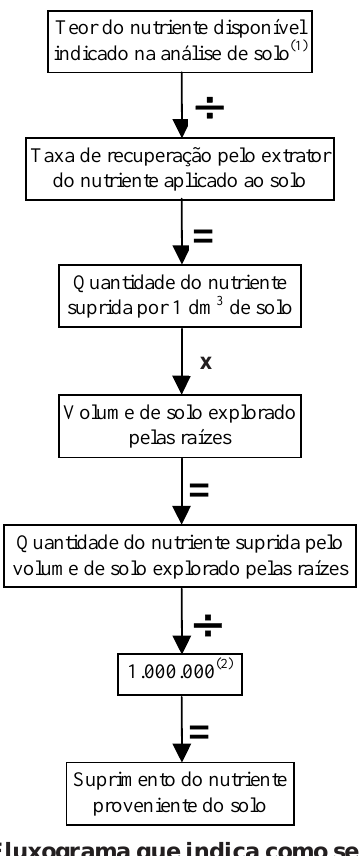
Figura 2. Fluxograma que indica como se estima o suprimento de um nutriente proveniente do solo. ( (1) Os teores de todos os nutrientes deverão ser expressos em mg dm -3 . (2) Fator para transformar mg ha -1 em kg ha -1